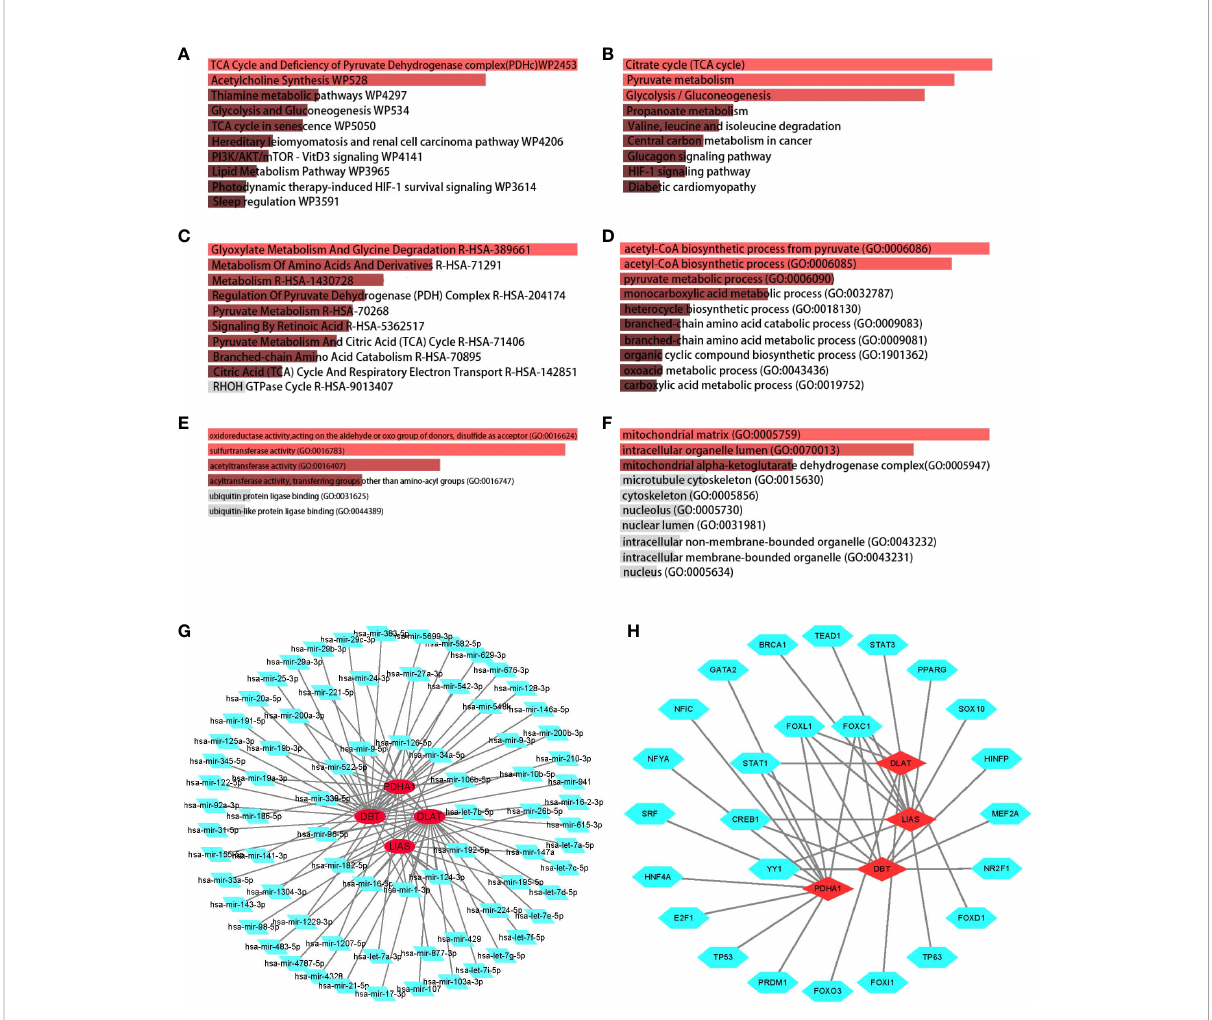
FIGURE 2 Determination of biological functions and gene regulatory pathway. The bar graphs of enrichment analysis of shared DEGs among CD, UC, CEL, and IBD-CA present that cuproptosis was closely related to mitochondrial respiratory functions. The enriched gene regulatory networks represent the association between genes and regulatory factors, red dots presented in circles represent the genes, and green diamond dots present miRNAs, green polygonal dots present TFs. (A) WikiPathway. (B) KEGG 2019 human pathway. (C) Reactome pathway. (D) Biological Processes. (E) Molecular Function. (F) Cellular Component. (G) DEGs-miRNA networks. (H) DEGs-TFs